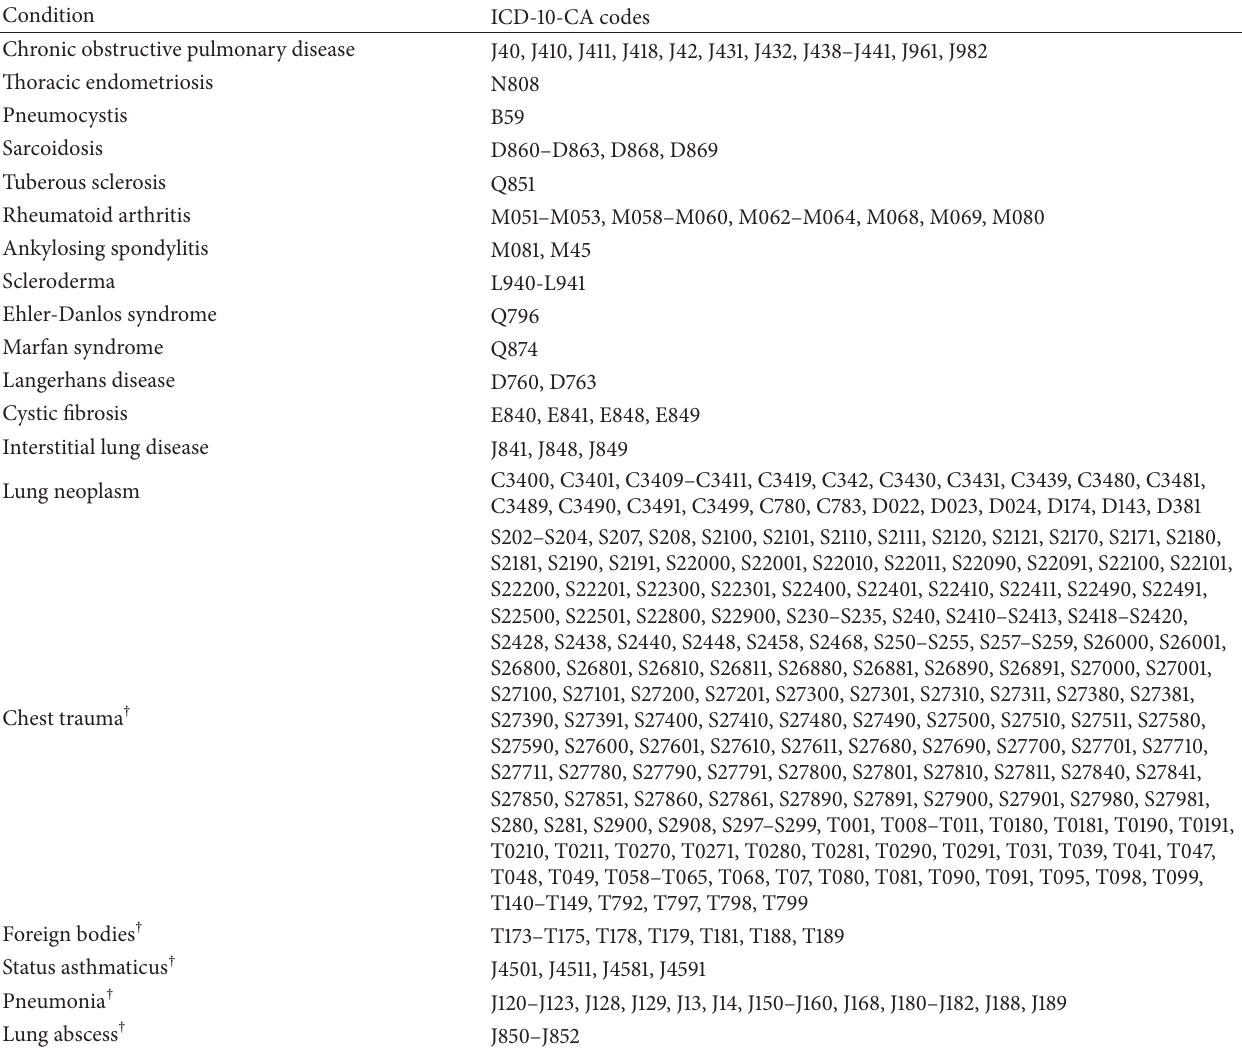
Table 1: Conditions identified as potential causes of secondary pneumothorax with corresponding ICD-10-CA